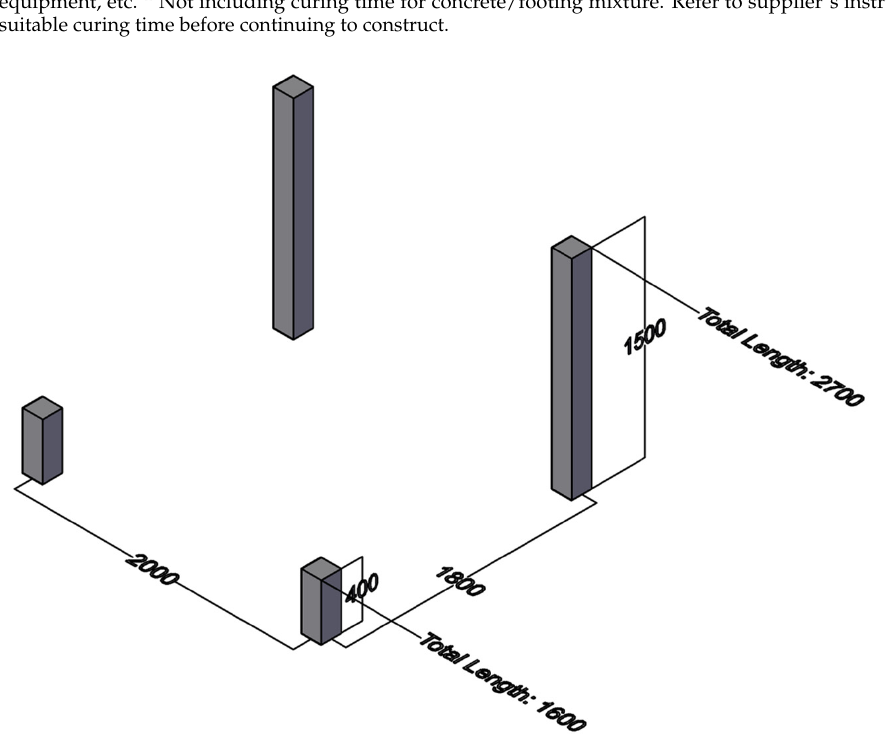
Figure 2. Center to center spacing of vertical posts for the 34-degree rack. Two 2 × 8 × 10 beams cut into 3 m pieces are to be installed as shown in Figure 4a. Use 2-1/2” brown deck screws to tighten the connection between the beams and the posts. Two 1/2” holes are drilled through the posts and beams as seen in Figure 4b, and 6” and 8” carriage bolts are inserted for the 4 × 4 and 6 × 6 posts, respectively. All carriage bolts are to be tightly secured with a washer and nut as shown in Figure 4c. A 2 × 4 bracing must be installed to enhance the system’s stability. Two 2 × 4 × 8 s are cut to 1.6 m to install from front post to back post, 300 mm above the ground as seen in Figure 5a. Another 2 × 4 × 8 is cut to 2 m to be installed between the first 2 × 4 s in the middle of the system, about 750 mm from the front posts. All 2 × 4 s are installed as shown in Figure 5b with 2 × 4 galvanized fence brackets and 1-1/2” joist hanger nails for stronger and more ductile connections. 2-1/2” brown deck screws should be used to further sink the 2 × 4 into the post, and to improve the connection’s resistance to